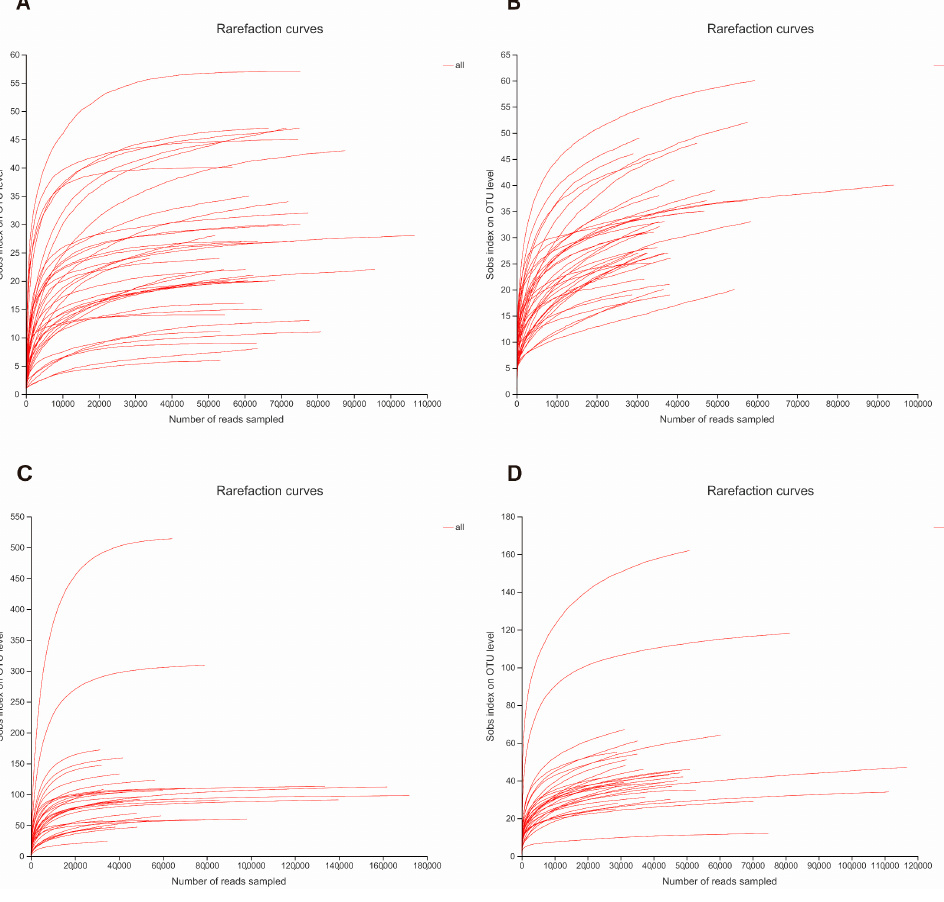
Figure 1. Rarefaction curve of each sample. ( A , B ) represent the rarefaction curves of 38 samples from Luokeng and Beilou. ( C , D ) represent the rarefaction curves of 31 samples from Gandong.